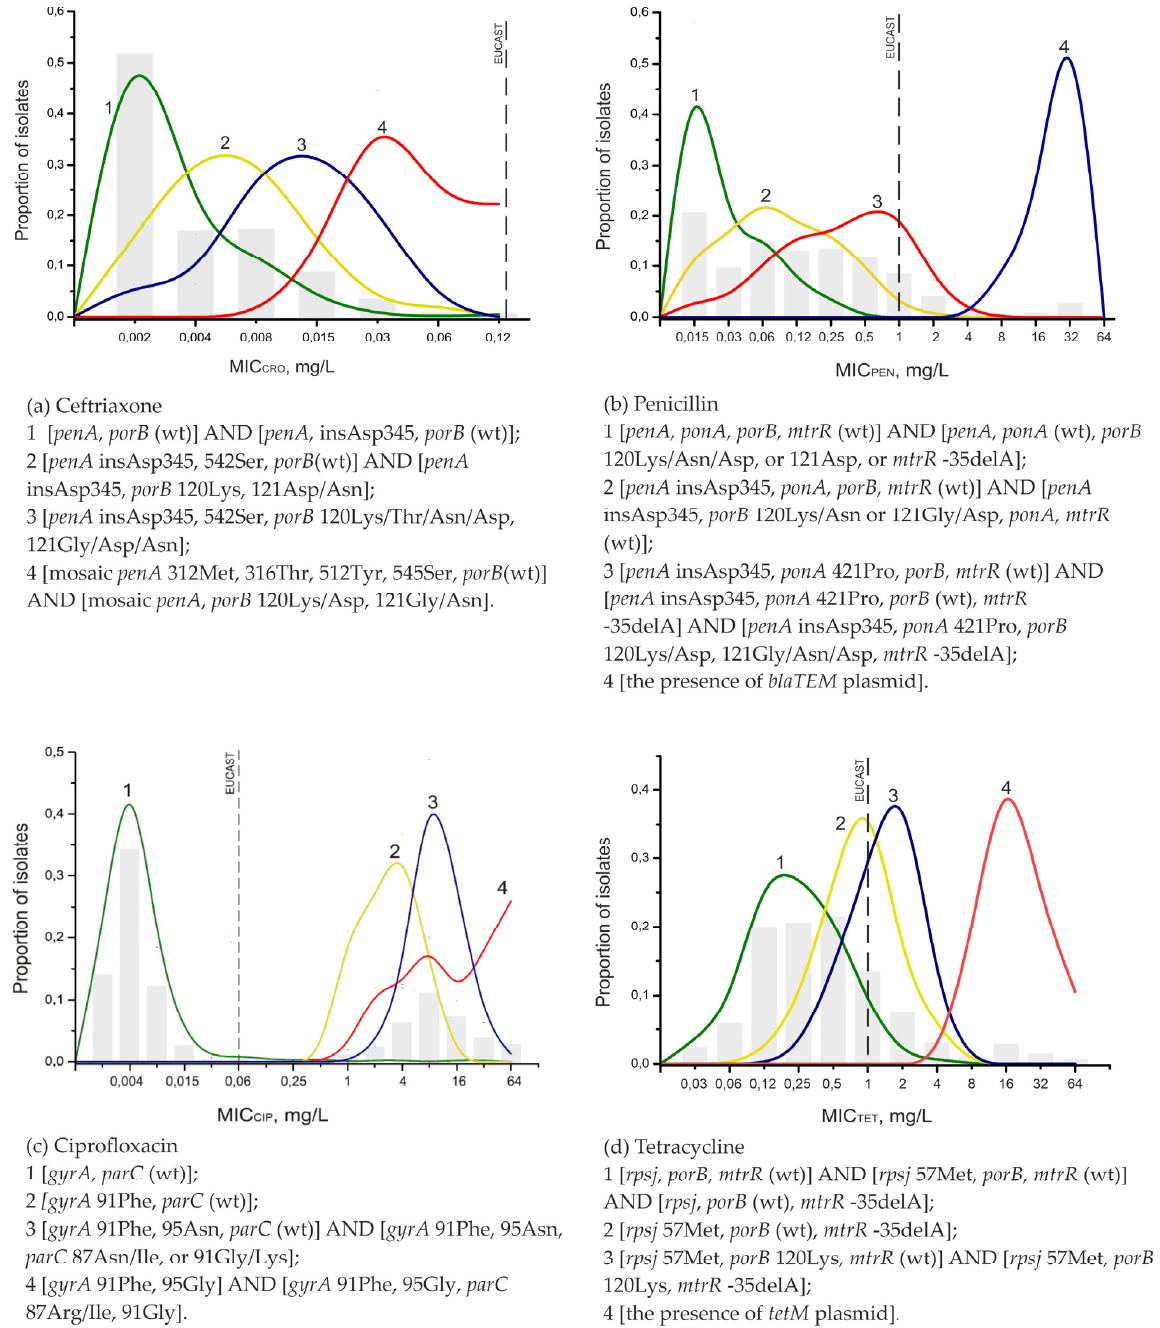
Figure 4. MIC distribution of N. gonorrhoeae isolates with different mutational profiles: ceftriaxone ( a ), penicillin ( b ), ciprofloxacin ( c ), tetracycline ( d ). The solid lines in the graphs indicate the proportion of isolates with a given MIC relative to the number of isolates with a given profile. The gray bars show the proportions of isolates with a given MIC relative to the total number of isolates. The vertical lines mark the breakpoints between susceptibility and resistance in isolates according to the EUCAST criteria. Abbreviation: wt—wild type.